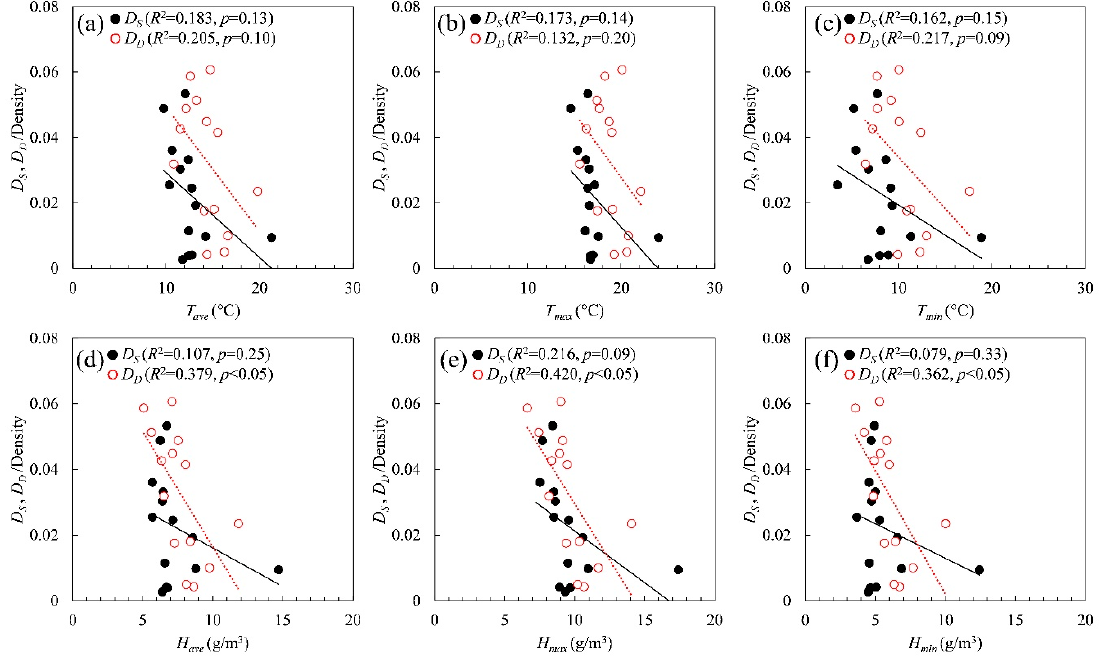
Figure 5. Relationship of the spread and decay durations ( D S and D D ) with ( a ) daily average temperature ( T ave ), ( b ) daily maximum temperature ( T max ), ( c ) daily minimum temperature ( T min ), ( d ) daily average absolute humidity ( H ave ), ( e ) daily maximum absolute humidity ( H max ), and ( f ) daily minimum absolute humidity ( H min ). Table 4. Spearman’s rank correlation coefficients and p -values for spread and decay durations normalized by population density.